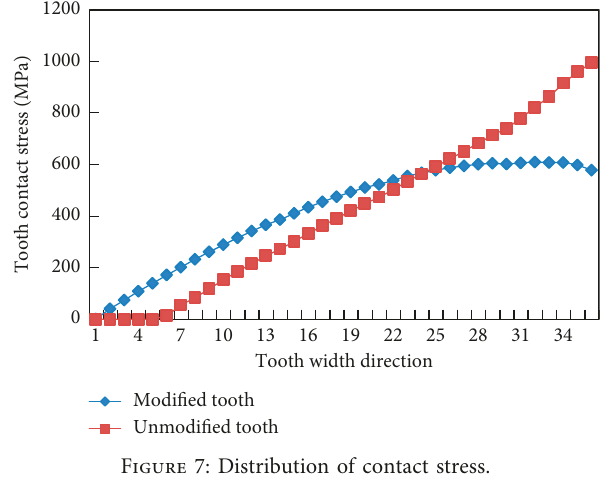
Figure 7: Distribution of contact stress.